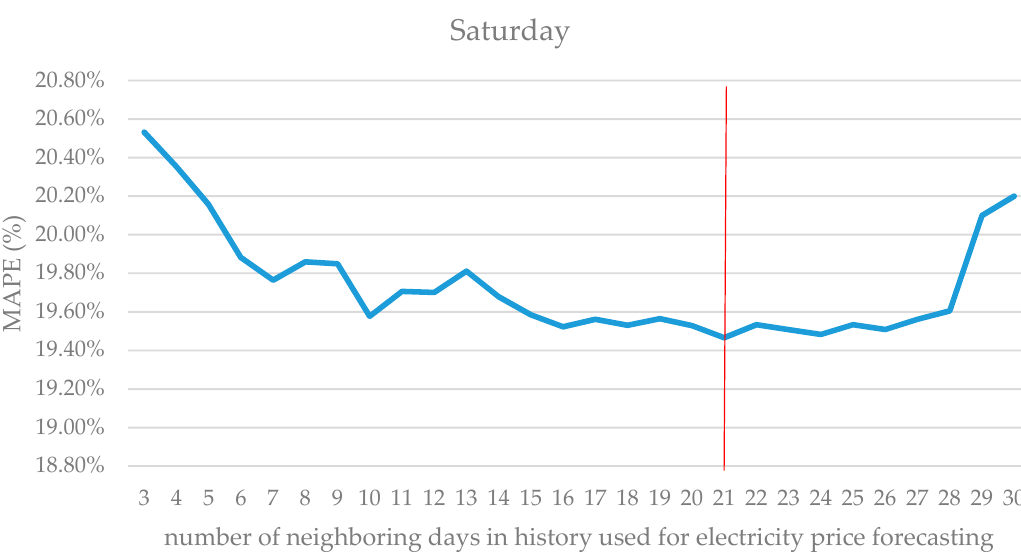
Figure 10. Correlation between price forecasting error and the size of a similar day data set for working days.